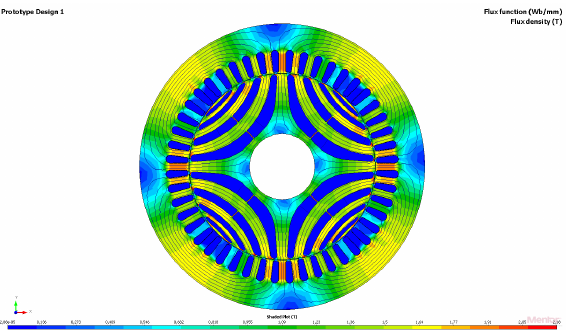
Figure 6. Flux density distribution under rated load